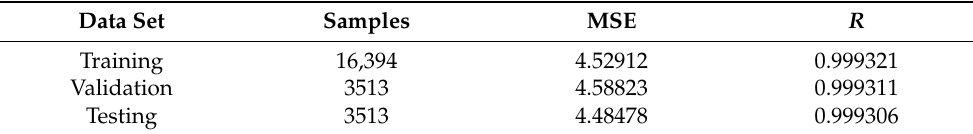
Table 1. Error metrics for artificial neural network (ANN) model for indentation depth.